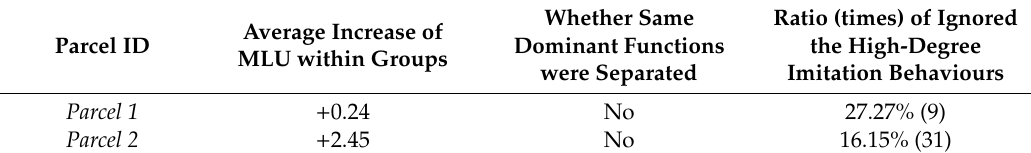
Figure 17. Illustration of grouping results based on UPG: ( a ) grouping result of Parcel 1 and ( b ) grouping result of Parcel 2 . Numbers within groups represent the MLU index.